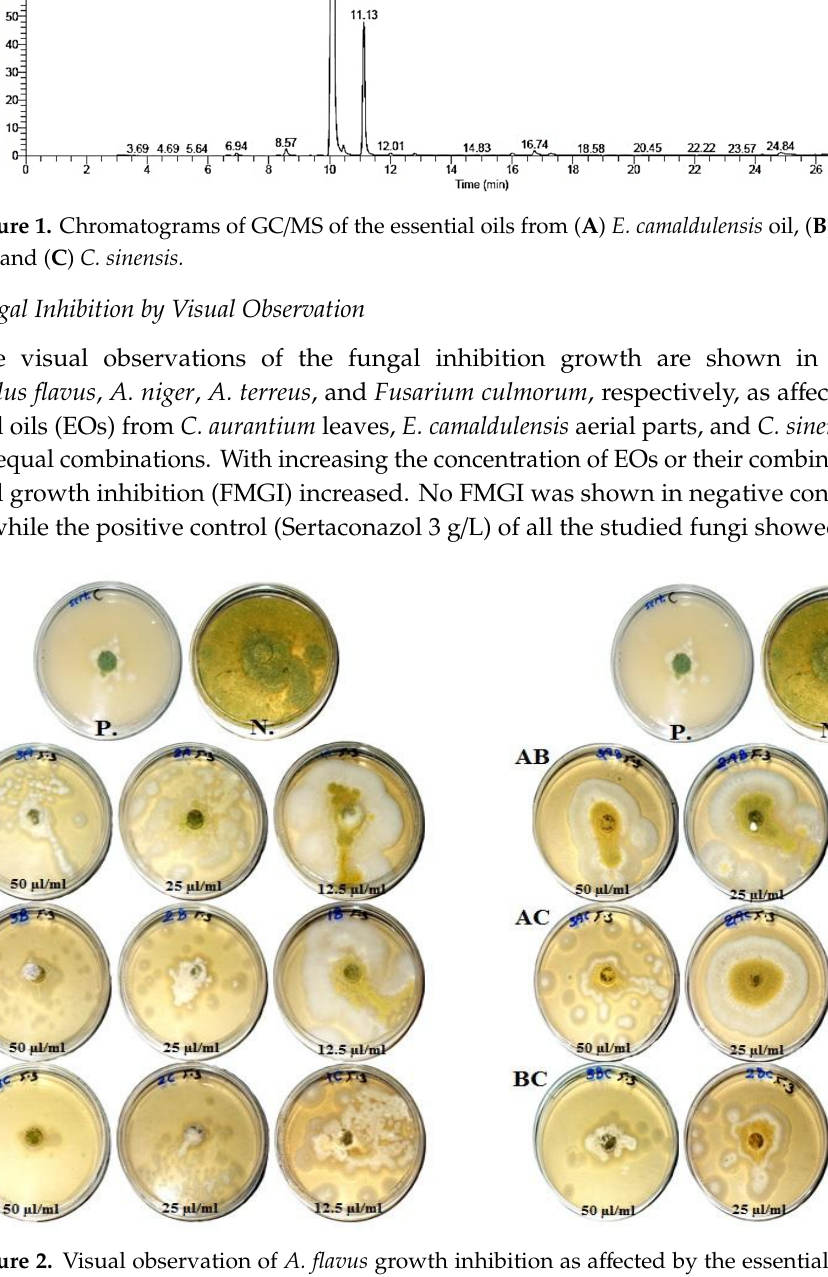
Figure 3. Visual observation of A. niger growth inhibition as affected by the EOs from ( A ) C. aurantium oil, ( B ) E. camaldulensis oil, and ( C ) C. sinensis oil and their combinations . ( P ) Positive control